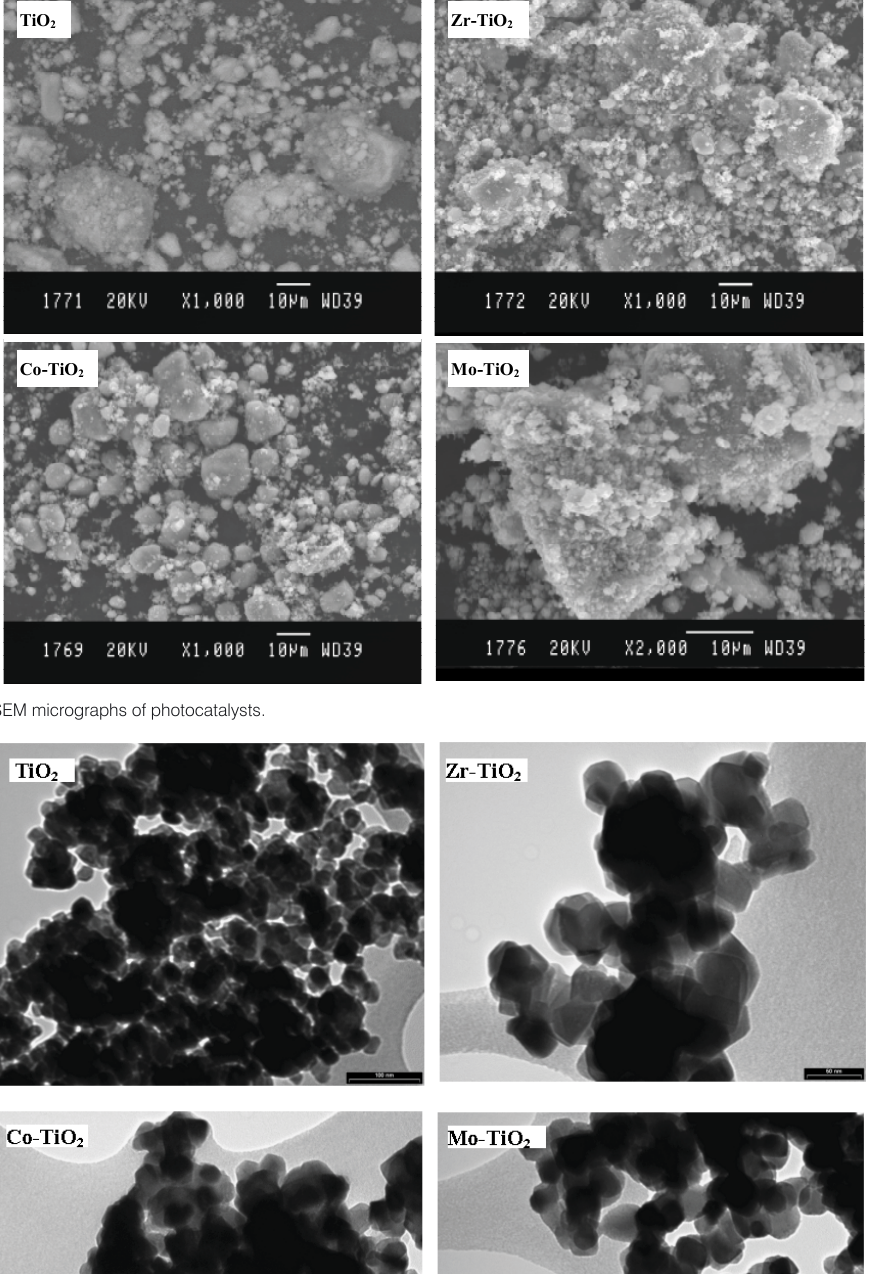
Figure 3. TEM micrographs of photocatalysts.